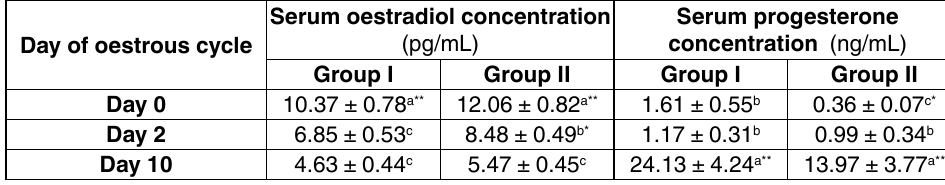
table 3. Comparison of serum oestradiol (pg/mL) and progesterone (ng/mL) concentrations during different periods of oestrous cycle in cows with and without metoestrual bleeding Day of oestrous cycle